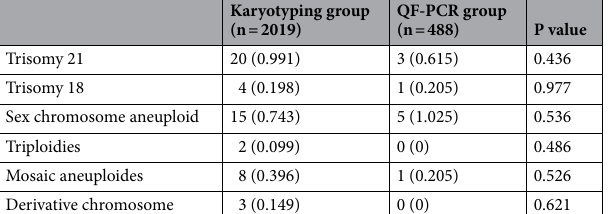
Karyotyping group (n =